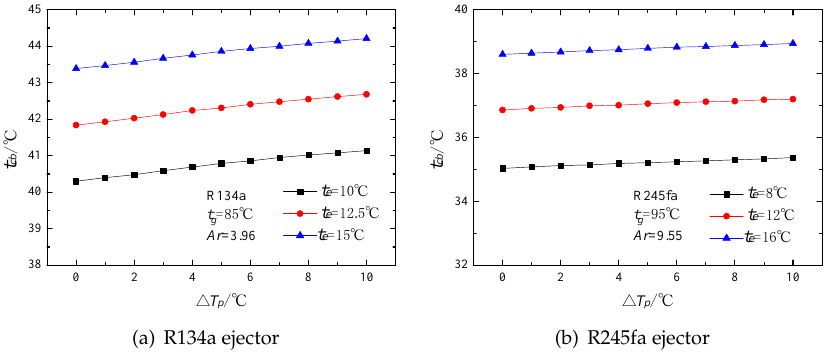
Figure 21. Breakdown condensing temperature versus the primary superheating (cid:52) T p for R134a and R245fa